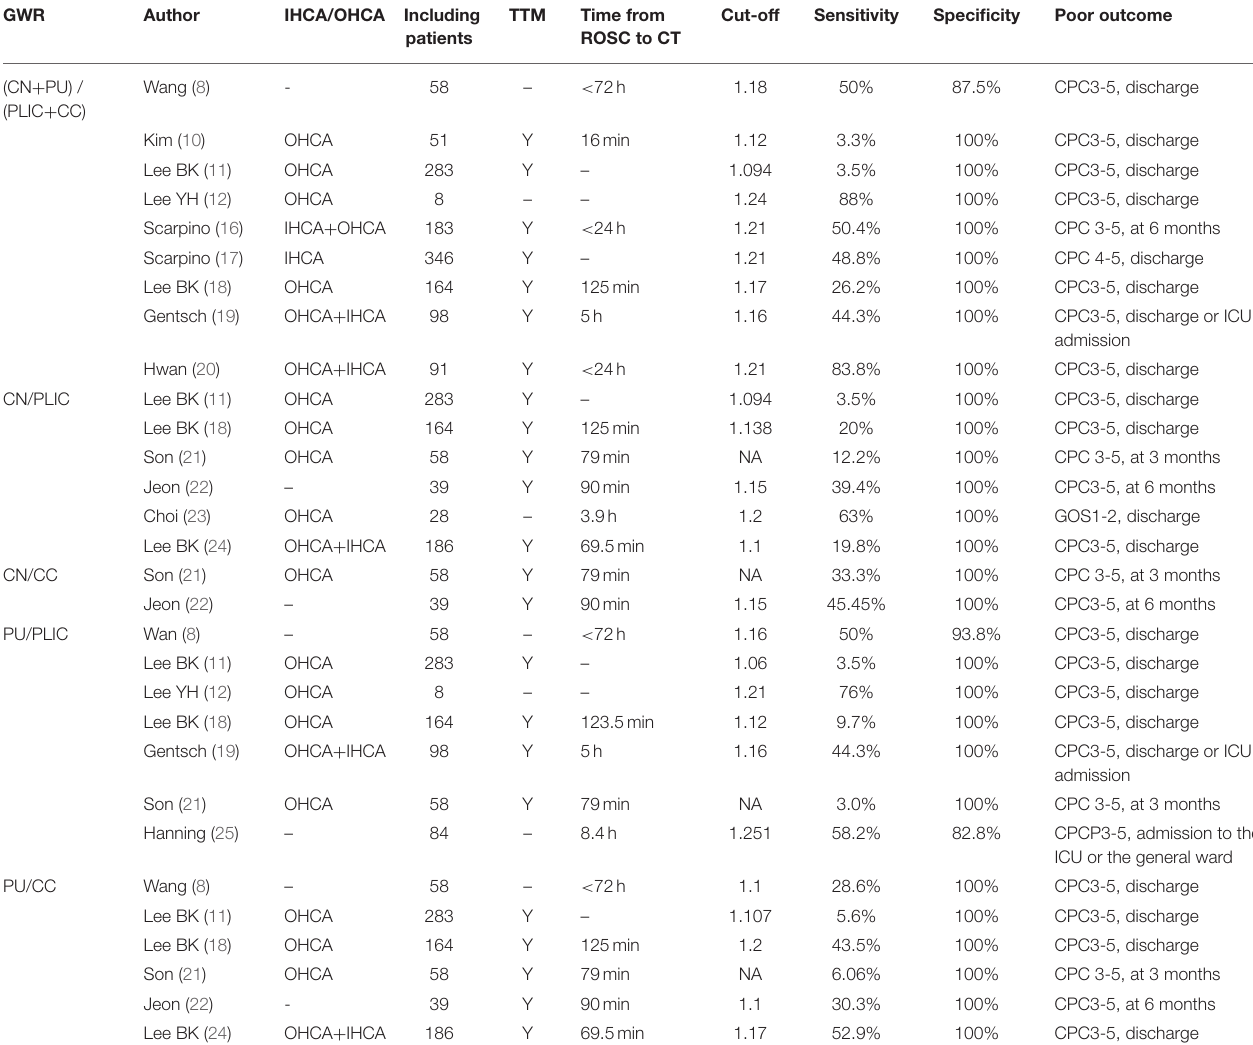
TABLE 2 | The sensitivity of Gray-white matter ratio at the basal ganglia (GWR-BG) in predicting poor neurologic outcomes in cardiac arrest survivors.